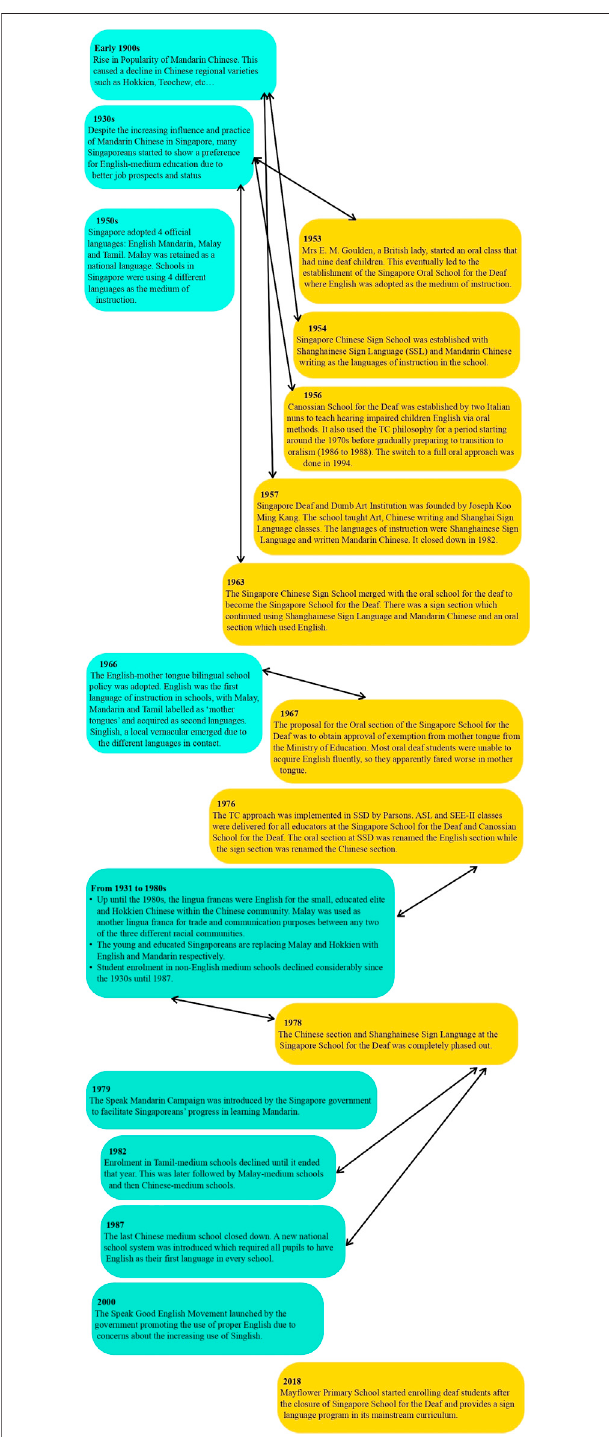
FIGURE 1 | Development of language policy and education in the broader Singapore context and the Singapore deaf community.